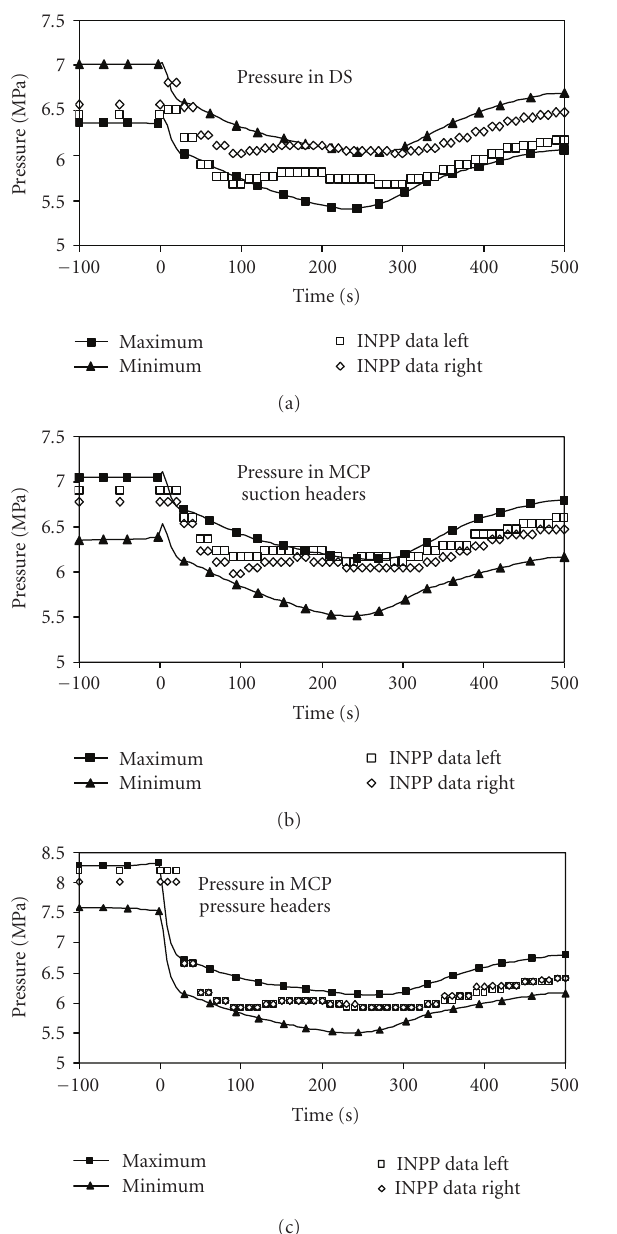
Figure 5: Loss-of-all-MCPs event. Pressure in the MCC.